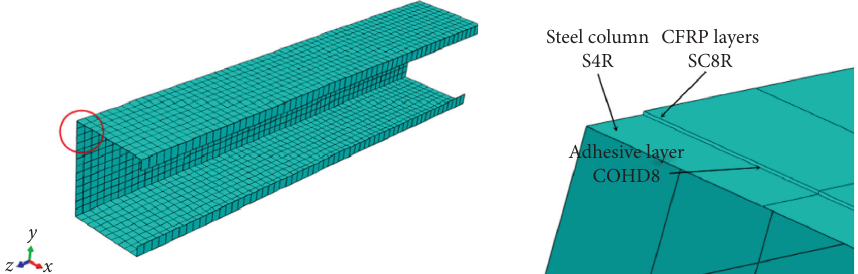
Figure 1: FE model of CFRP-strengthened cold-formed thin-walled C-section steel column.